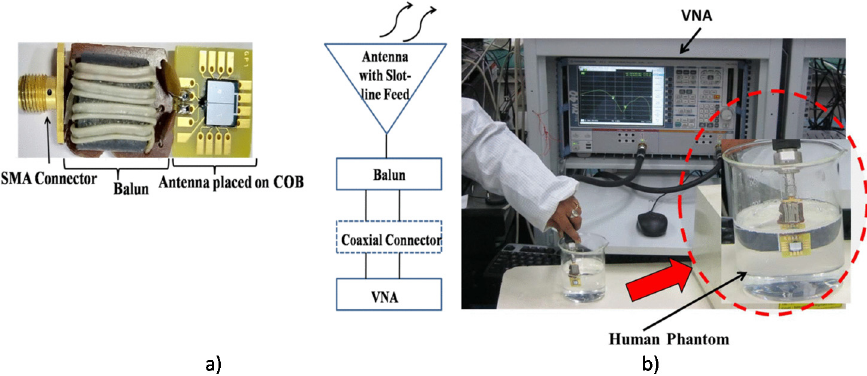
Figure 16. Antenna for wireless capsule endoscopy (WCE) application. ( a ) Antenna Assembly and ( b ) measurement set up for fabricated antenna [228].